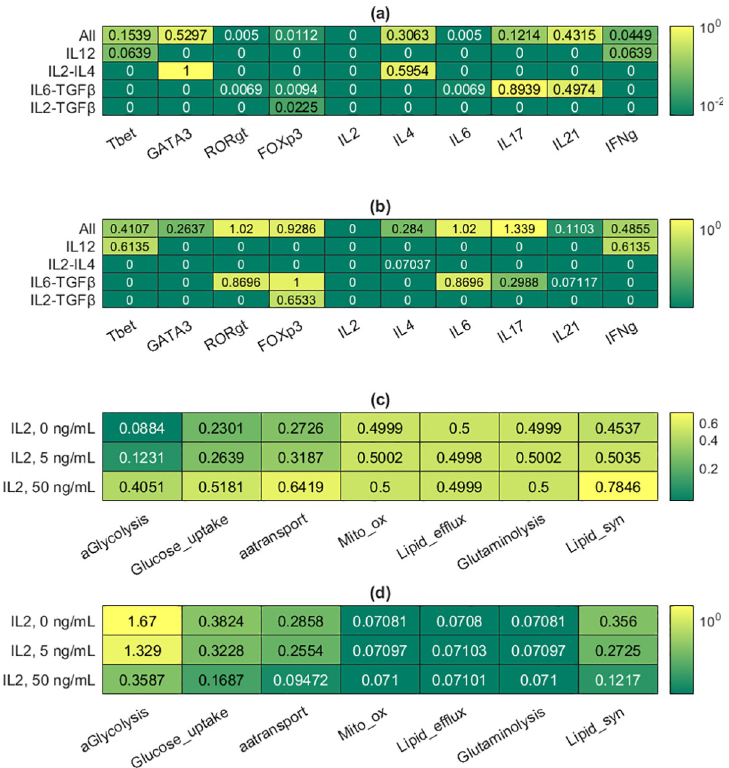
Fig 4. Representative results from the logical models. Details about how the molecular models were used on their own can be found in Methods and S1 Text. (a) Mean activity levels of selected components of the logical model in the estimates of attractors corresponding to different cytokine inputs. (b) Standard deviation values associated with the mean activity levels in (a); each standard deviation was divided by its associated mean to generate the tabulated values. (c) Mean activity levels of all the metabolic components of the logical model in the estimates of attractors corresponding to different IL2 input levels (0, 5, and 50 ng/mL). 5 ng/mL is the baseline concentration. (d) Standard deviation values associated with the mean activity levels in (c); each standard deviation was divided by its associated mean to generate the tabulated